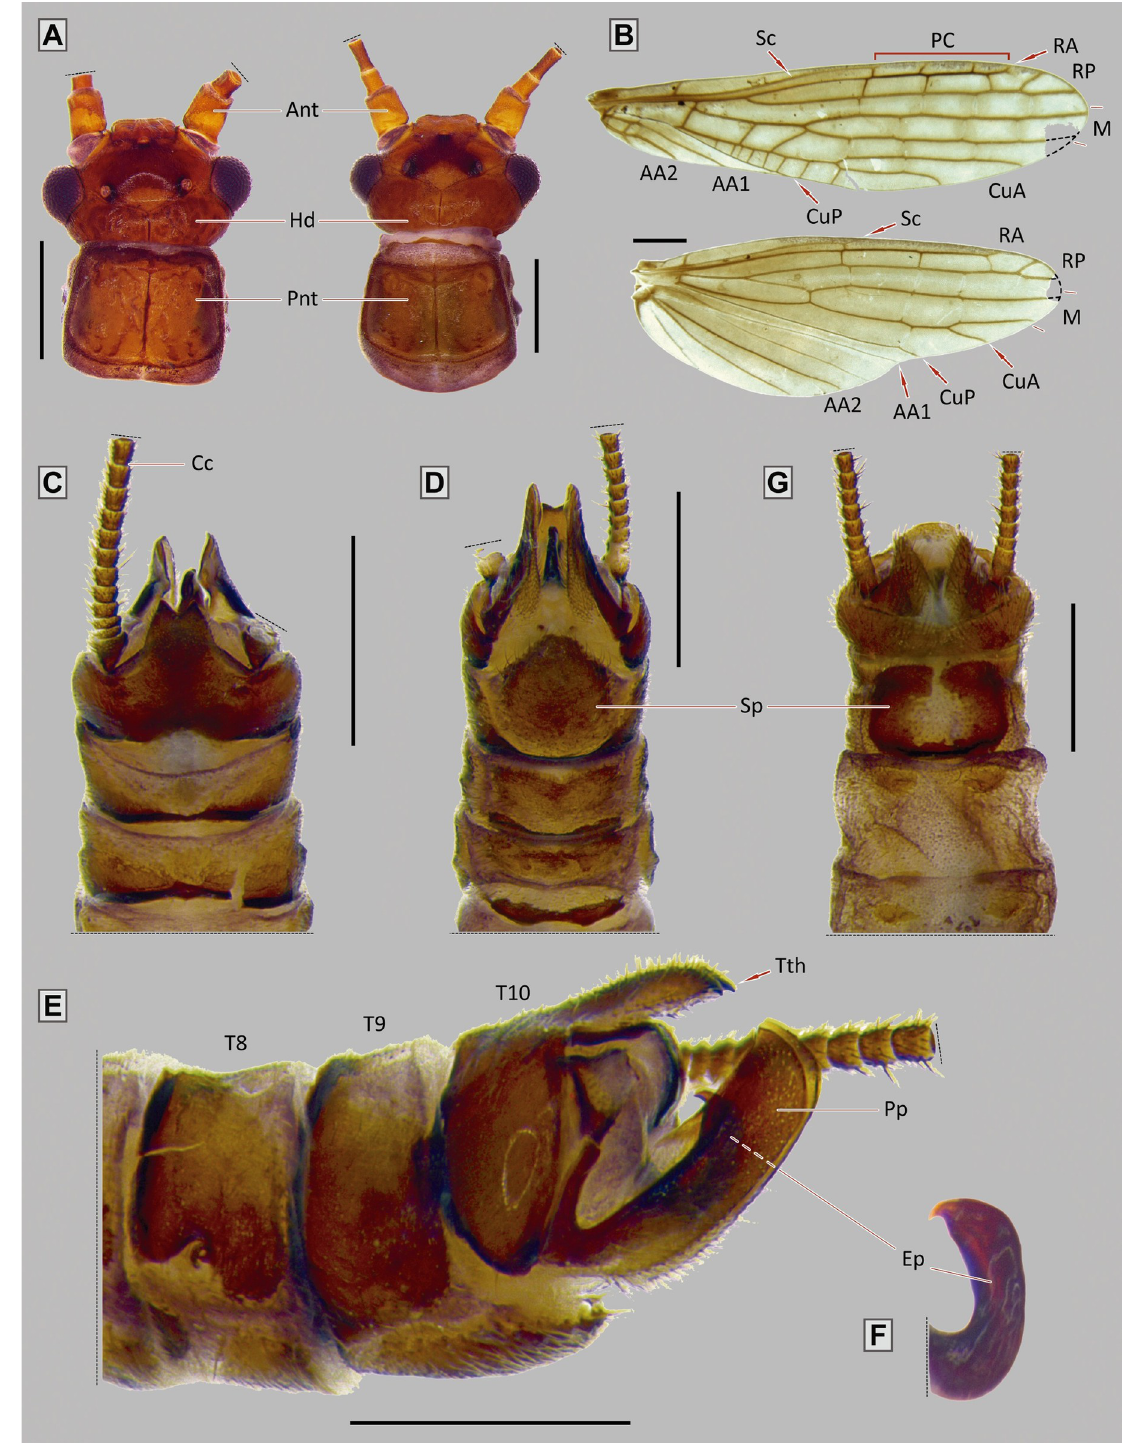
Fig 5. Paragripopteryx dasalmas sp. nov. (A) Left–holotype adult male, head and pronotum in dorsal view; right–adult female, head and pronotum in dorsal view. (B) Male fore- and hind wings. (C , D , E) Male terminalia in dorsal, ventral and lateral views, respectively. (F) Detail of the epiproct. (G) Female terminalia in ventral view (Scale bars: A, B, C, D: 0.5 mm; E, G: 0.4 mm).